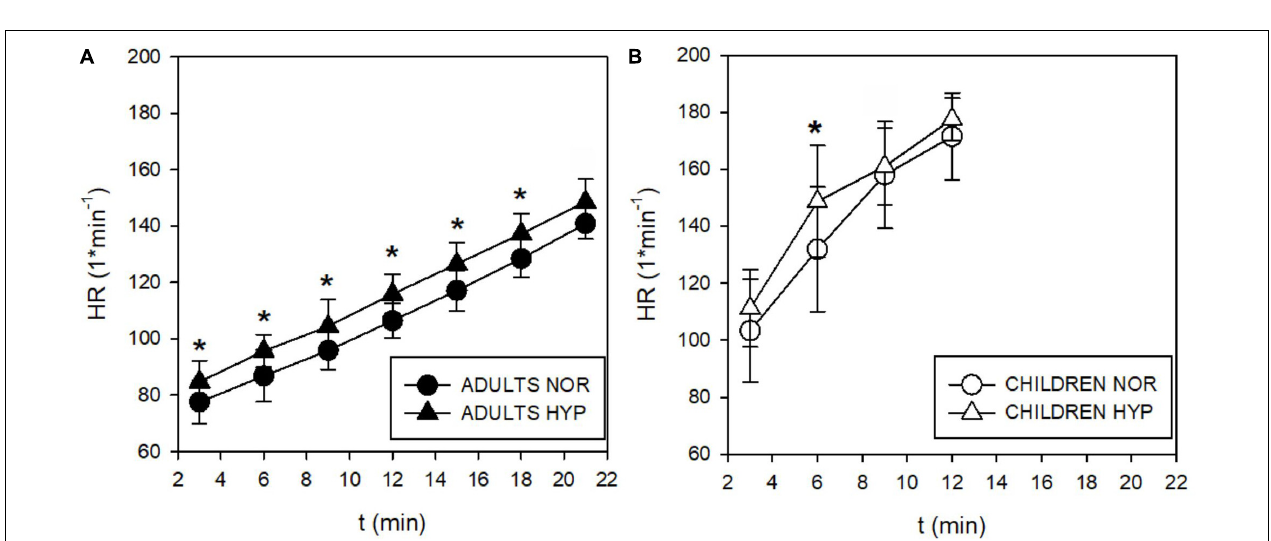
FIGURE 4 | Time course of the heart rate (HR) responses during incremental test in adults (A) and children (B) . The HR increased by 11 beats · min − 1 throughout the whole test ( ∗ p < 0.05). Children didn’t enhance their HR in spite of a tendency for increases observed below their GET at 3 and 6 min in hypoxia ( (cid:49) ).